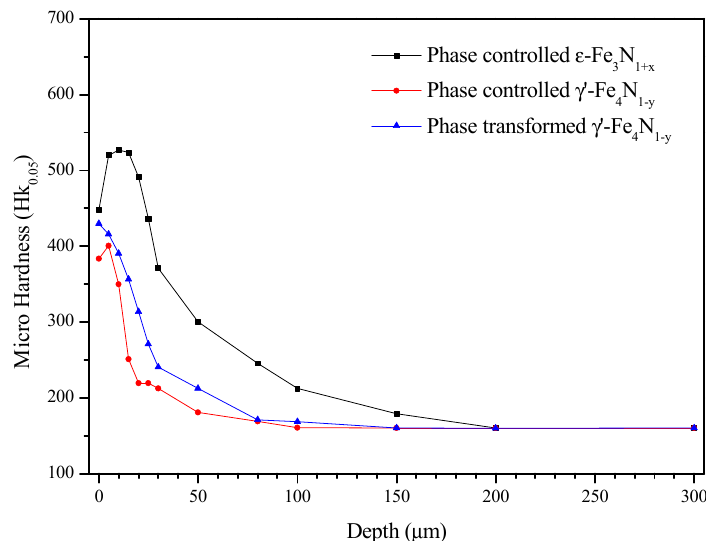
Figure 8. Microhardness profiles obtained on gas-nitrided pure iron with 1.4, 0.38 and 1st step: 1.4 and 2nd step: 0.38 of nitriding potential at 570 °C.